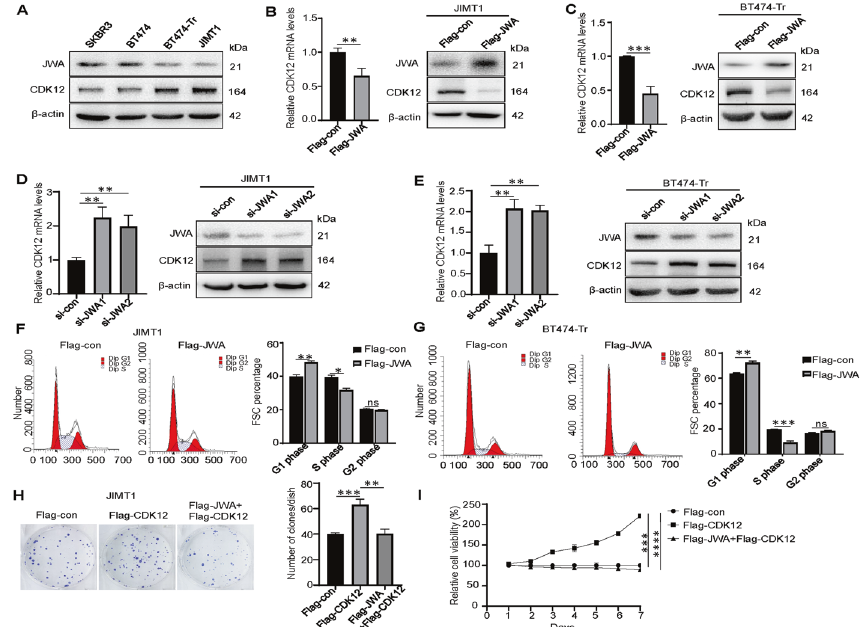
Fig. 6 JWA inhibits proliferation and facilitates apoptosis in trastuzumab-resistant breast cancer via downregulating CDK12 in vitro. A JWA and CDK12 were measured in different HER2 + breast cancer cells by Western blot. B , C Overexpression of JWA signi fi cantly downregulated CDK12 expression in JIMT1 and BT474-Tr cells by qRT-PCR and Western blot. D , E Knocking down of JWA signi fi cantly upregulated CDK12 expression in JIMT1 and BT474-Tr cells by qRT-PCR and Western blot. F , G Overexpression of JWA in JIMT1 and BT474-Tr cells was detected by fl ow cytometer, and it arrested cell cycle at the G1/S phase in trastuzumab-resistant breast cancer cells. H , I Overexpression of CDK12 in JIMT1 cell promoted proliferation, and further overexpression of JWA inhibited proliferation as determined by colony formation assays and CCK8. * P < 0.05, ** P < 0.01, *** P < 0.001, **** P <